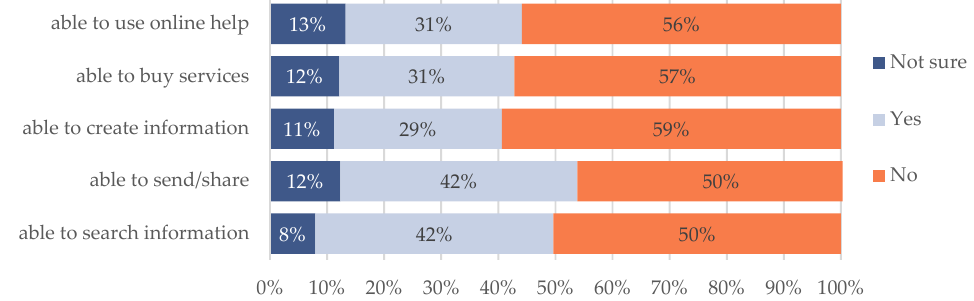
Figure 2. Marginalized people’s digital device usage (n = 220).